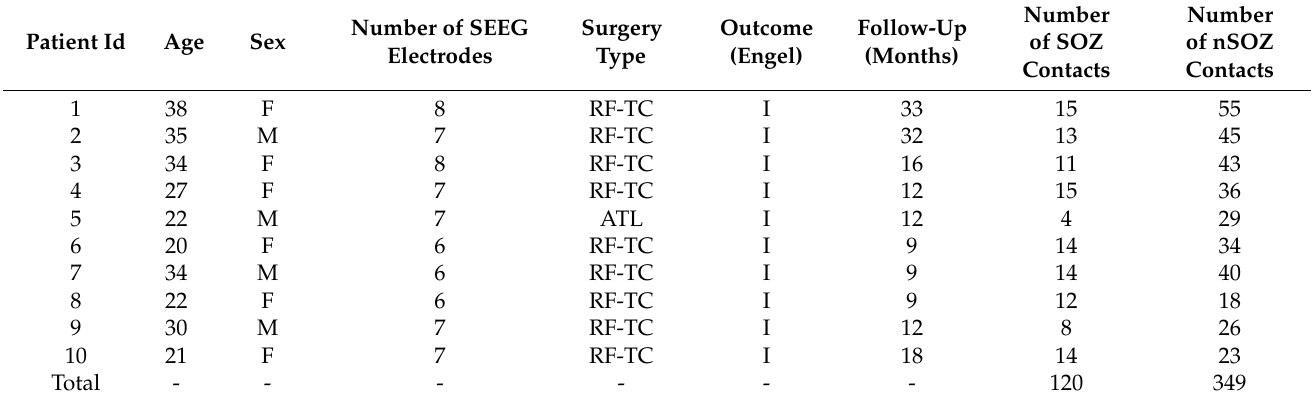
Table 3. The clinical dataset’s patient characteristics.